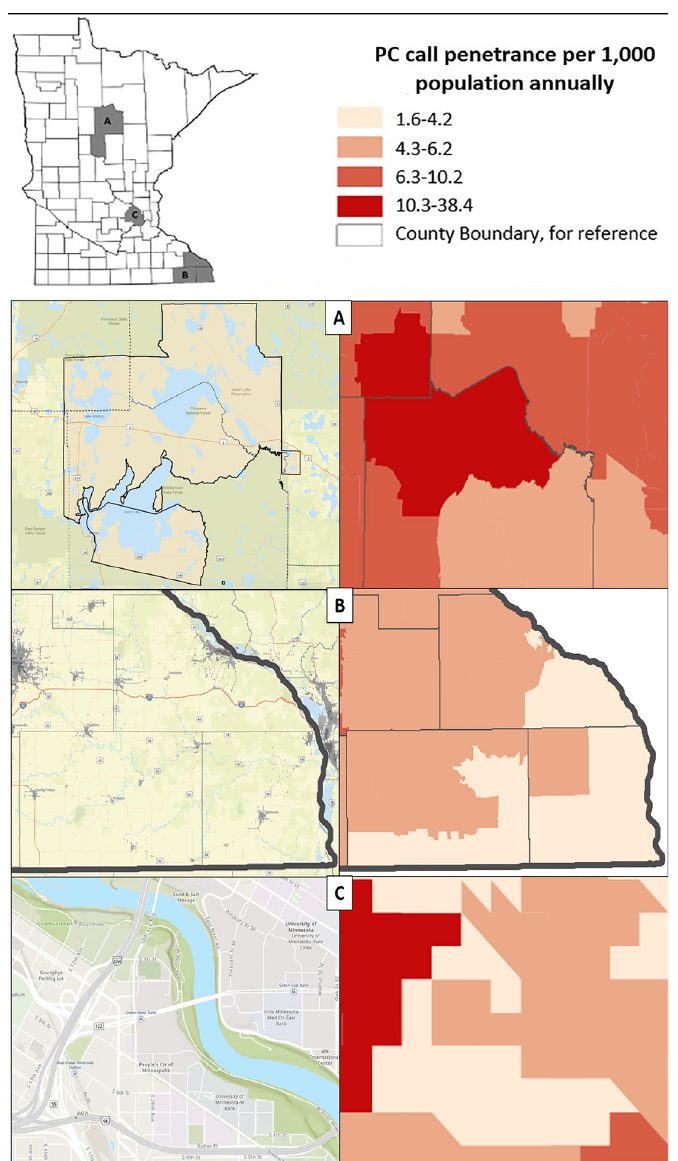
Figure 3. Case examples. A) High penetrace region at